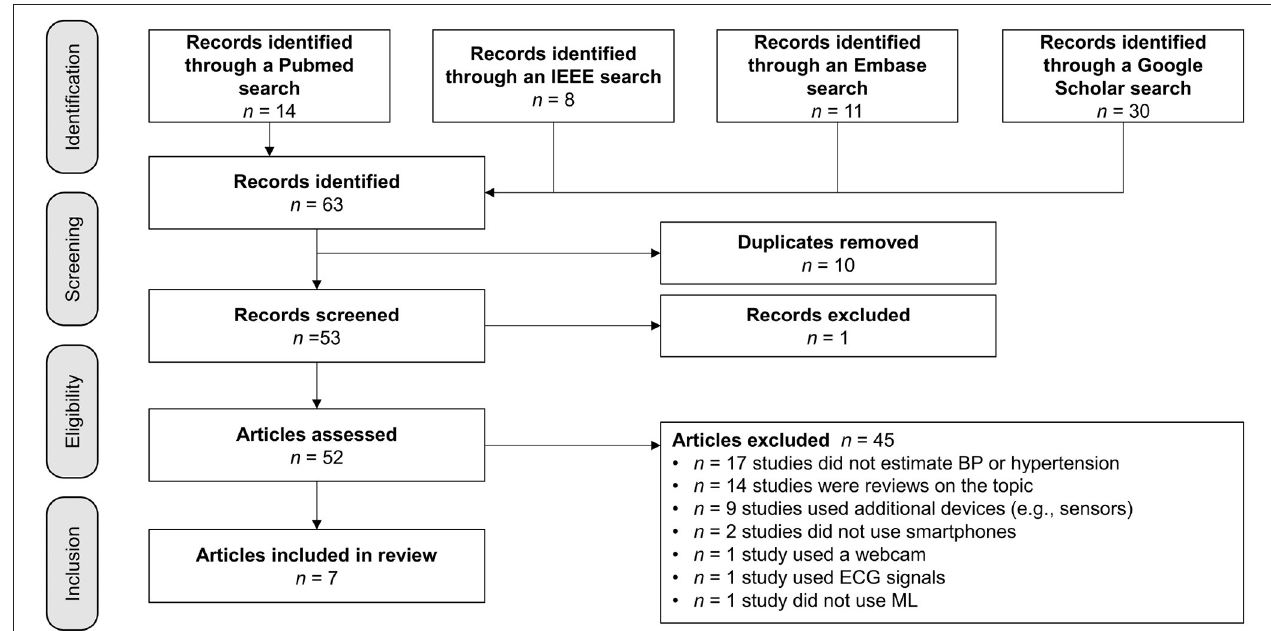
FIGURE 1 | Search strategy: Filter for relevant publications.